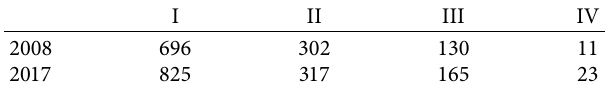
Table 2: Scale grade of primary schools in Liaoning Province in 2008 and 2017.